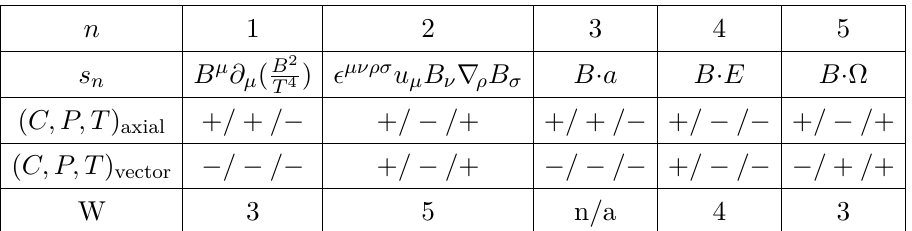
. An µ and the vorticity Ω µ = (cid:15) µνρσ u λ u ν ∂ ρ u σ